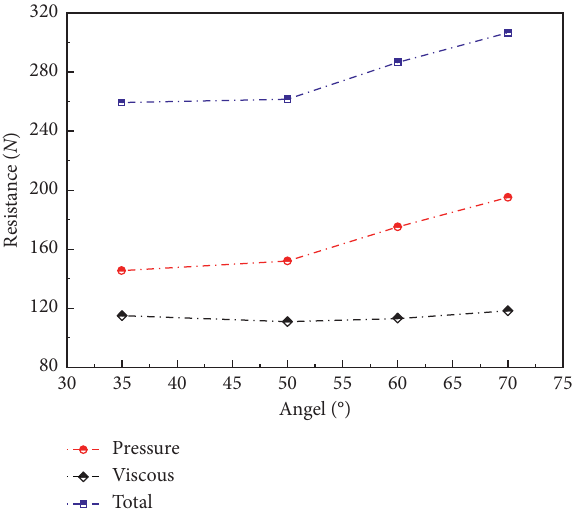
Figure 6: Total resistance variation chart.